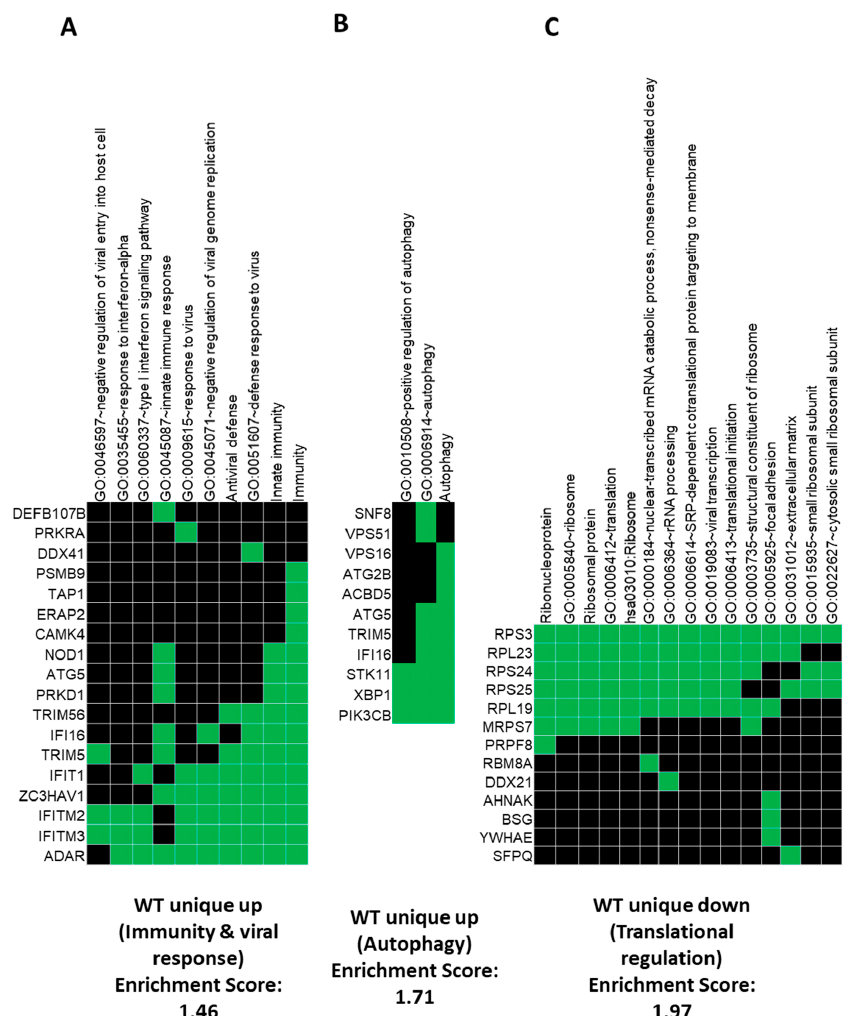
Figure 3. The specific genes involved in given gene ontology for uniquely expressed up and